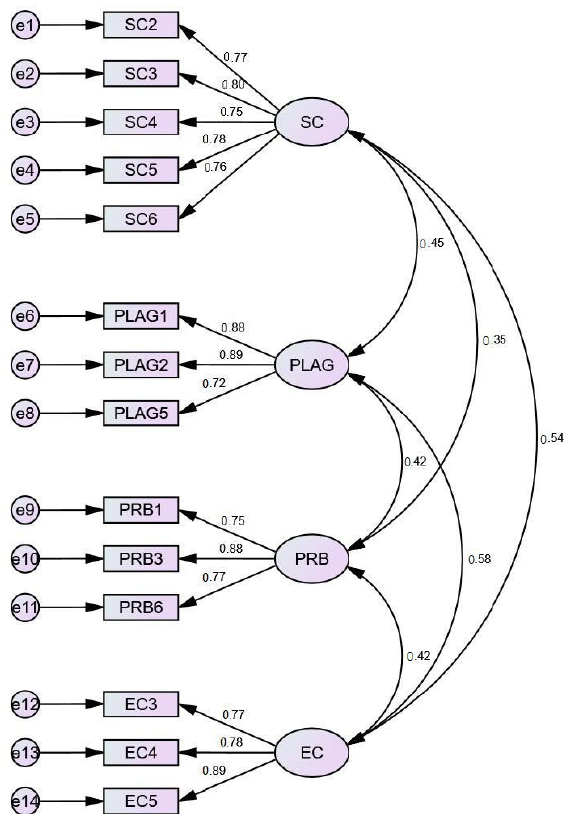
Figure 1. Four-factor model of HBS. Note: All coefficient values are standardized and they can be seen above the linked path. p < 0.05.